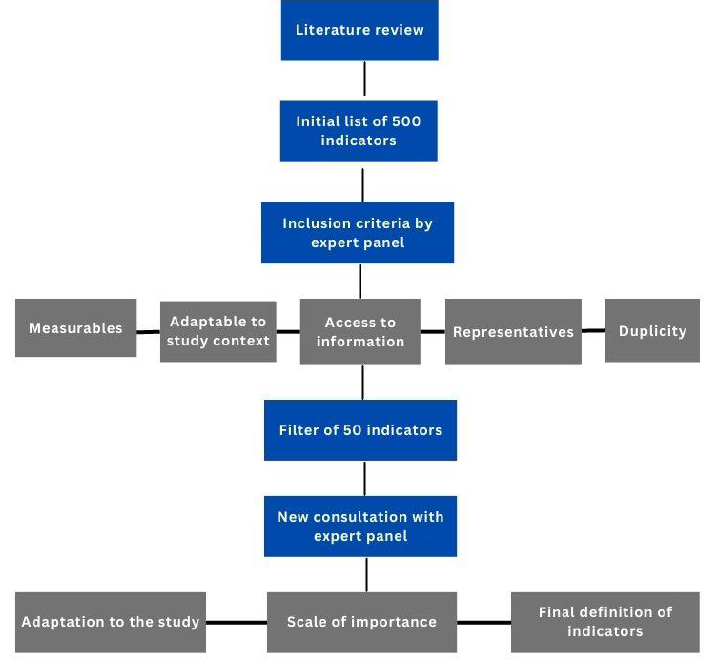
Figure 2. Explanatory diagram .